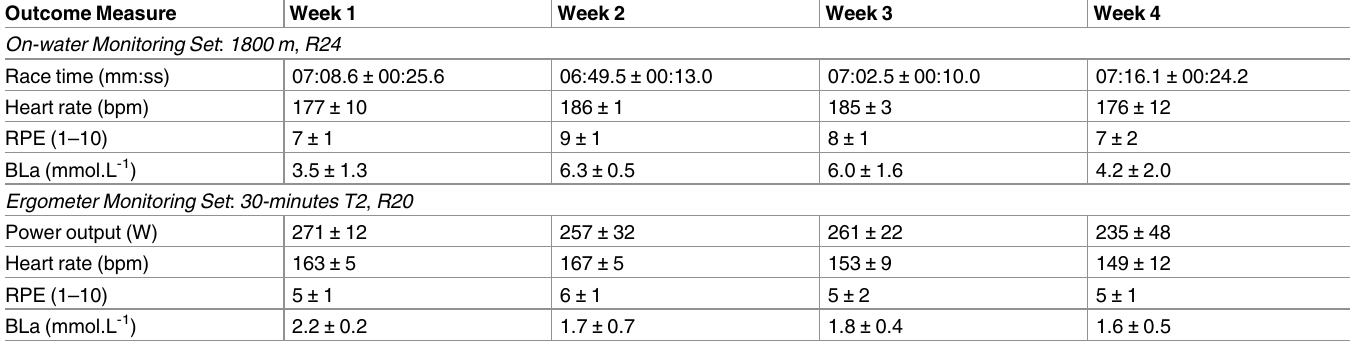
Table 4. Descriptivedata from weekly on-water and ergometer training sets throughout the four-week training cycle. Due to an insufficientsample, data are presented as mean ± SD for race time, heart rate, rating of perceivedexertion (RPE) and blood lactate concentration (BLa) duringan on-water1800 m piece at 24 strokes-per-minute; and power output, heart rate, RPE and BLa duringa 30-minute ergometer piece at 20